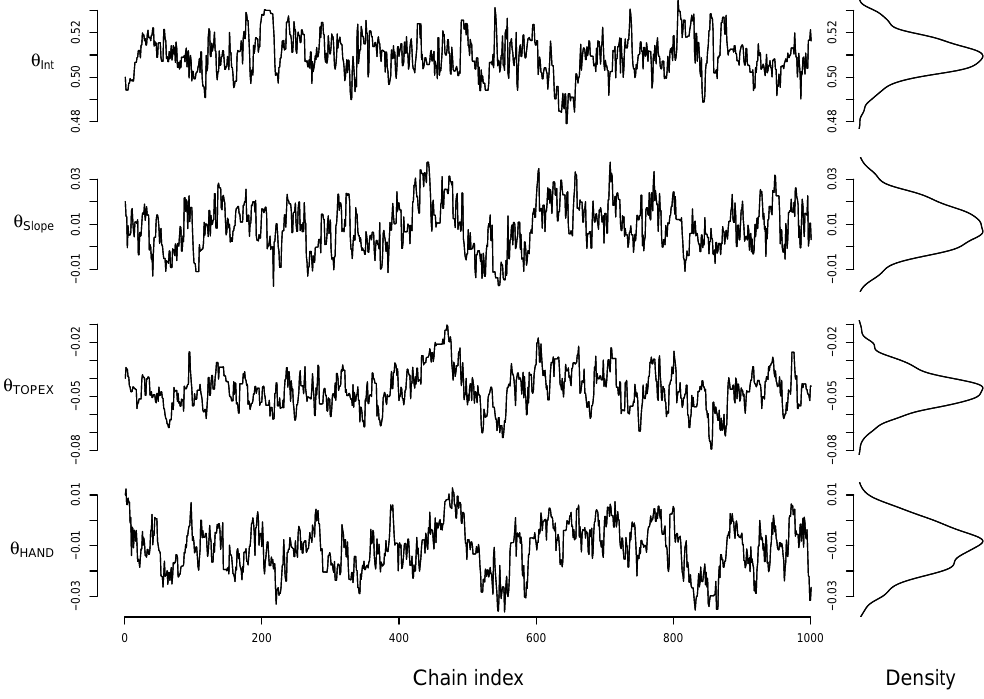
Figure 5. Posterior distribution of the environmental variables in the final multivariate